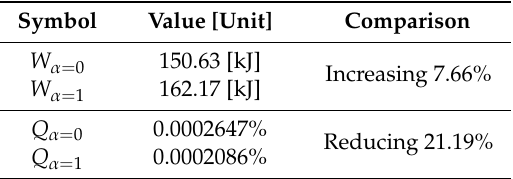
Figure 6. Capacity degradation and energy consumption simulation results of batteries under two cost functions ( α = 1 indicates that the battery life loss cost and the battery energy cost are comprehensively considered in the performance index; α = 0 means that only the battery energy cost is considered in the performance index). Table 4. Simulation results of di ff erent cost